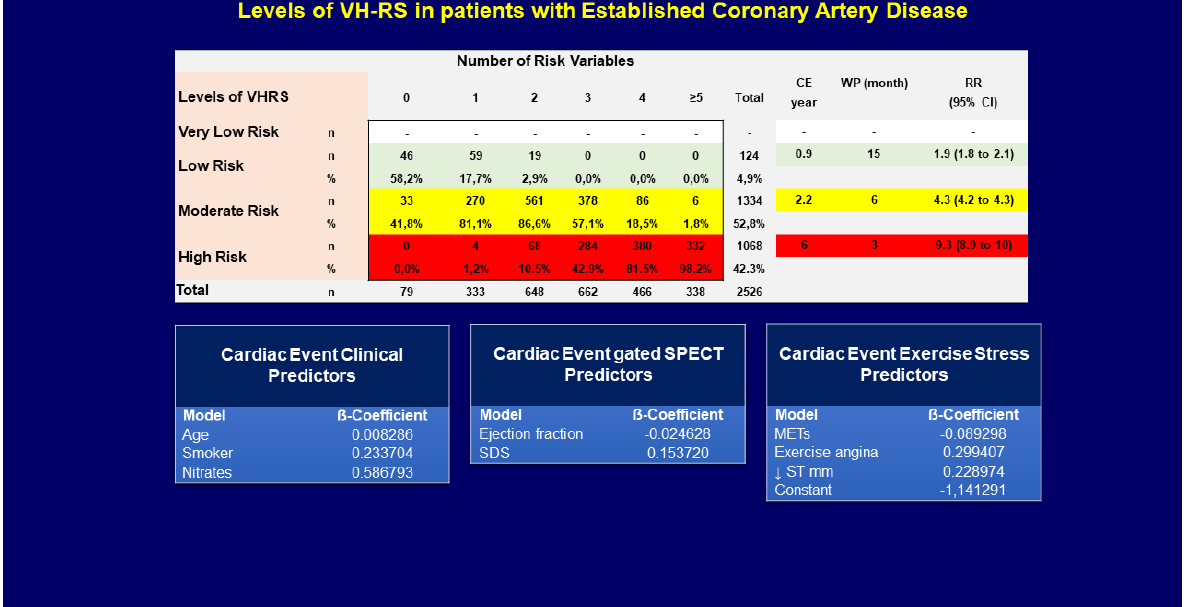
Figure 3. Relationship between VH-RS levels and the number of risk variables. The increase of risk level is associated with an increase in the number of predictor variables. All patients with a high-risk level have one or more risk variables, and the warranty period (WP) of an imaging test for detecting ischemia is very short (approximately 3 months). Very low-risk patients are unlikely to be found among patients with established CAD. CE, cardiac event; SDS, summed difference score; RR, relative risk.